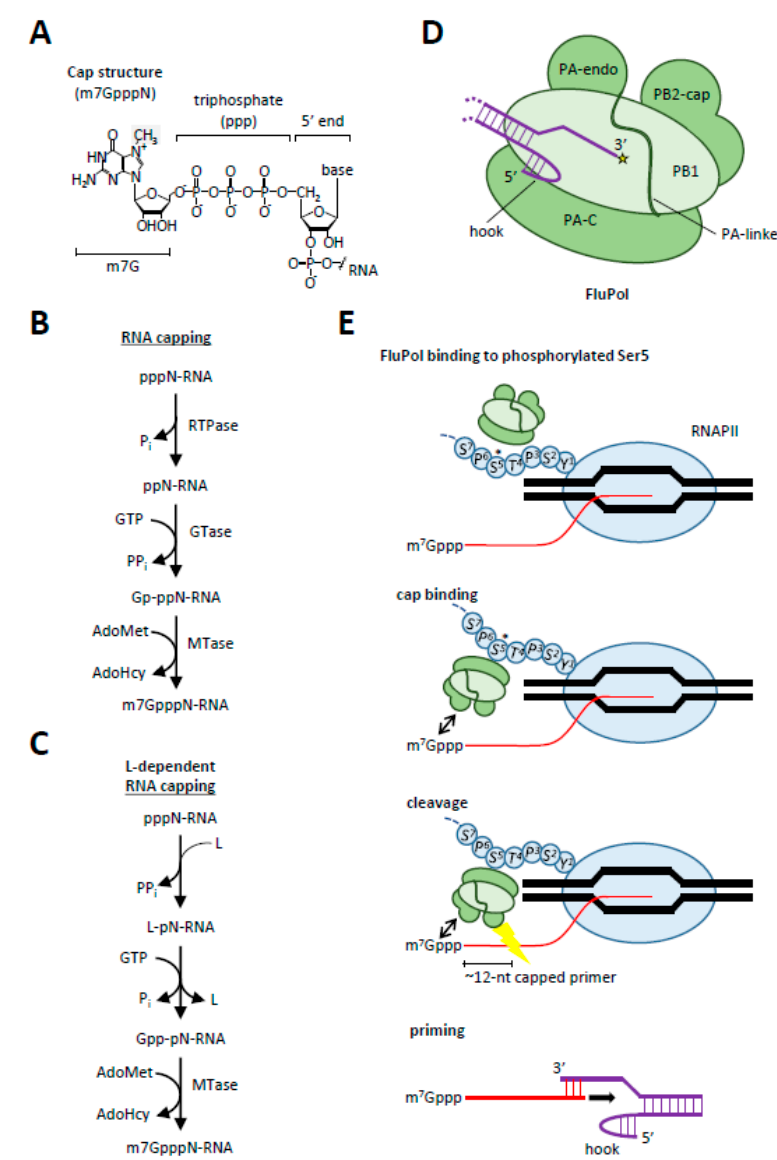
Figure 2. Capping mechanisms in RNA viruses. ( A ) The eukaryotic mRNA cap consists of a 7-methylguanosine linked to the initiator nucleoside of mRNA through the 5 ′ -5 ′ triphosphate bridge. The methyl group at the N7 position of the guanosine is shaded gray; ( B ) the conventional RNA capping pathway; ( C ) the L-dependent capping pathway utilized by negative-sense ssRNA viruses; ( D ) the FluPol complex with the polymerase acidic endonuclease (PA-endo), PA C-terminal (PA-C), polymerase basic 2 cap-binding (PB2-cap) and PB1 domains indicated. The influenza viral RNA (vRNA; purple) is circularized with the extreme 5 ′ end docked in a pocket formed by PA-C and PB1 and the 3 ′ end loaded in the FluPol active center (yellow star); ( E ) the first step in cap-snatching is the recognition and binding of FluPol to the phosphorylated Ser5 of RNAPII through its PA-C domain. This will allow the PB2-cap domain to bind the cap and to direct the nascent RNA towards PA-endo. After cleavage the nascent RNA will be loaded into the active domain of FluPol where it will be used to prime the 3 ′ end of the vRNA, allowing elongation of the RNA primer from 5 ′ to 3 ′ direction (indicated with black arrow).